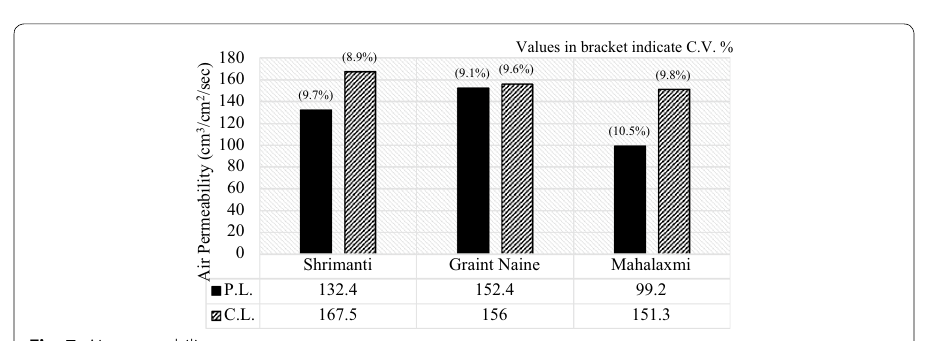
Values in bracket indicate C.V. %